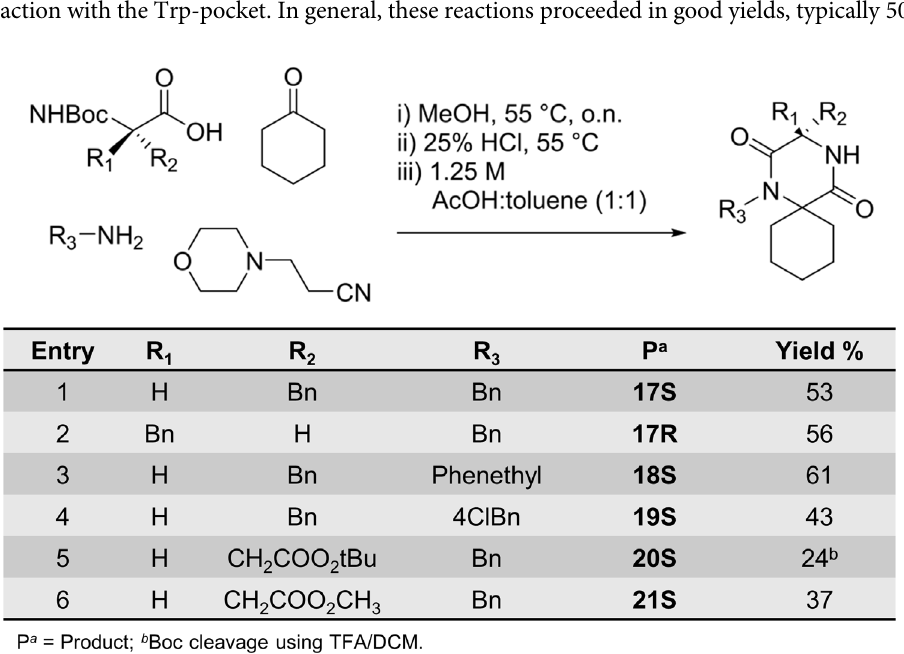
Fig 8. Synthesis of spiro-2-DKPs 17 –